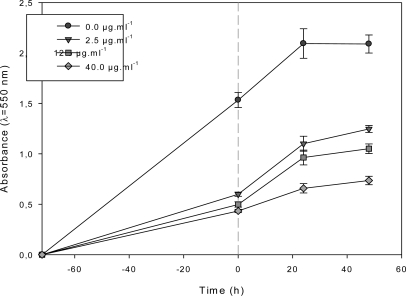
Growth kinetics of MCF-7 during discontinuous exposure to the DT DCM sub-fraction F1.4 Change to control medium was made at t0 (gray dots).